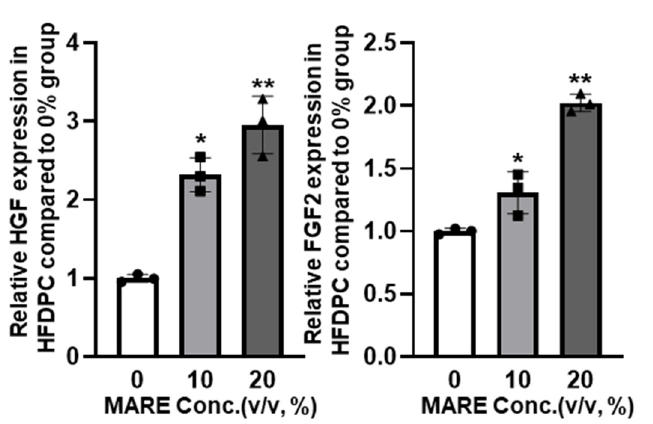
Figure A1. Effect of MARE on hepatocyte growth factor (HGF) and fibroblast growth factor 2 (FGF2) expressions in HFDPCs ( n = 3, * p < 0.05, ** p < 0.001 compared to 0% group).